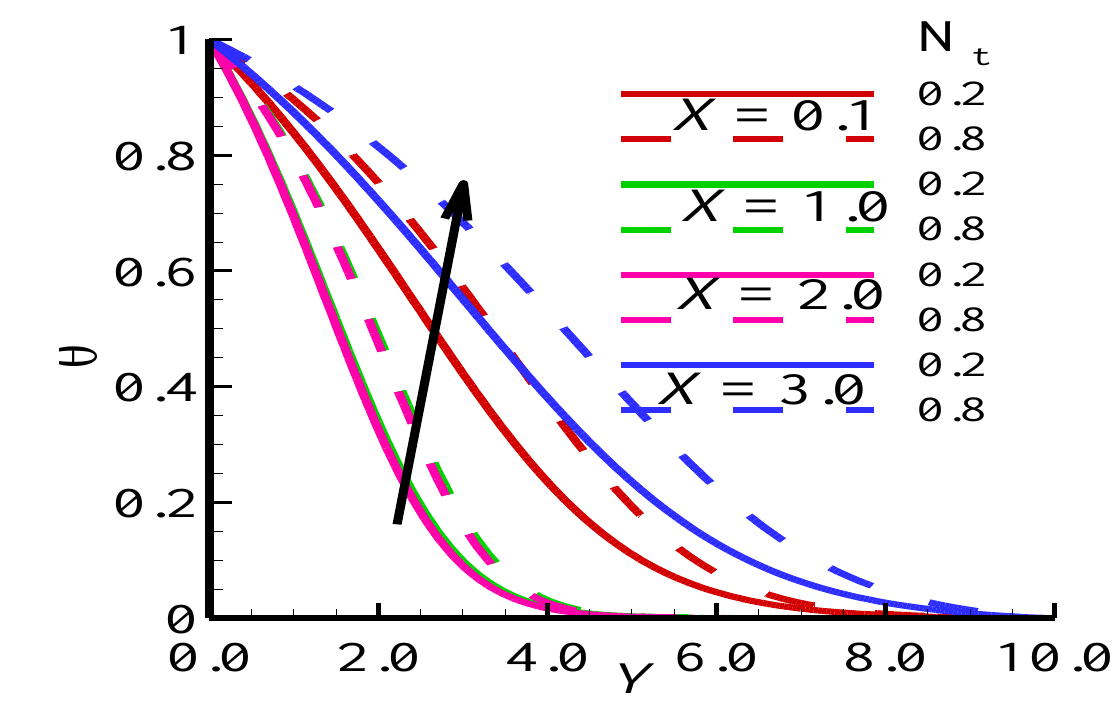
Figure 6. Outcomes of thermophoresis parameter 𝑁 𝑡 on temperature distribution 𝜃 when N = 0.5, Nb = 1.5, Pr = 7.0, and Sc = 10.0.